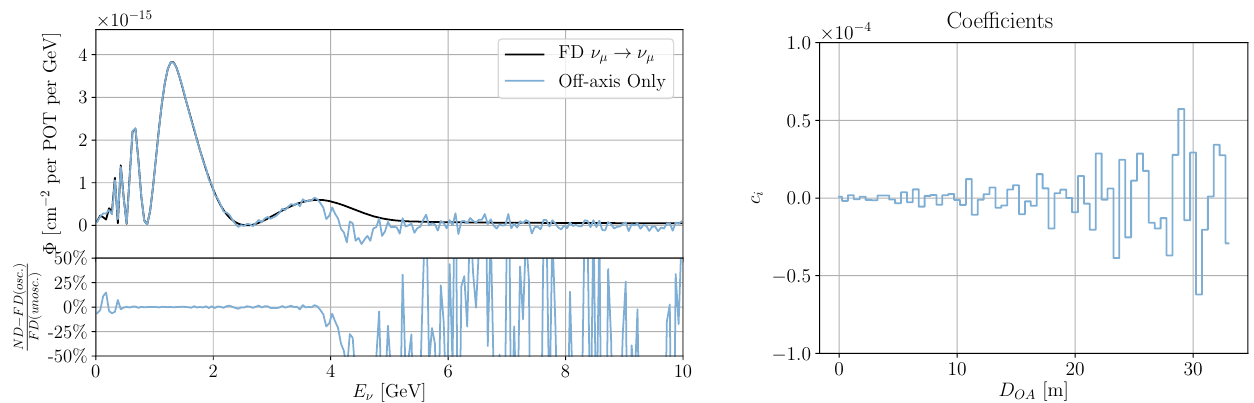
Figure 102. The FD flux and the ND linear combination flux match ( left ) and corresponding coefficients ( right ) are shown using the solution of Equation